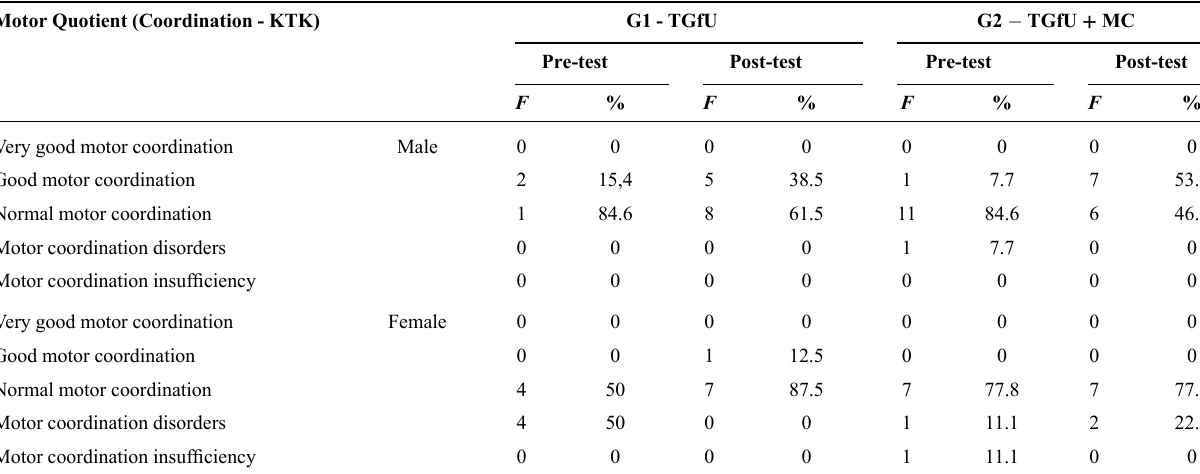
Table 2 - Absolute and relative frequency of the motor coordination classification, pre and post pedagogical intervention for both groups and genders. Motor Quotient (Coordination - KTK)